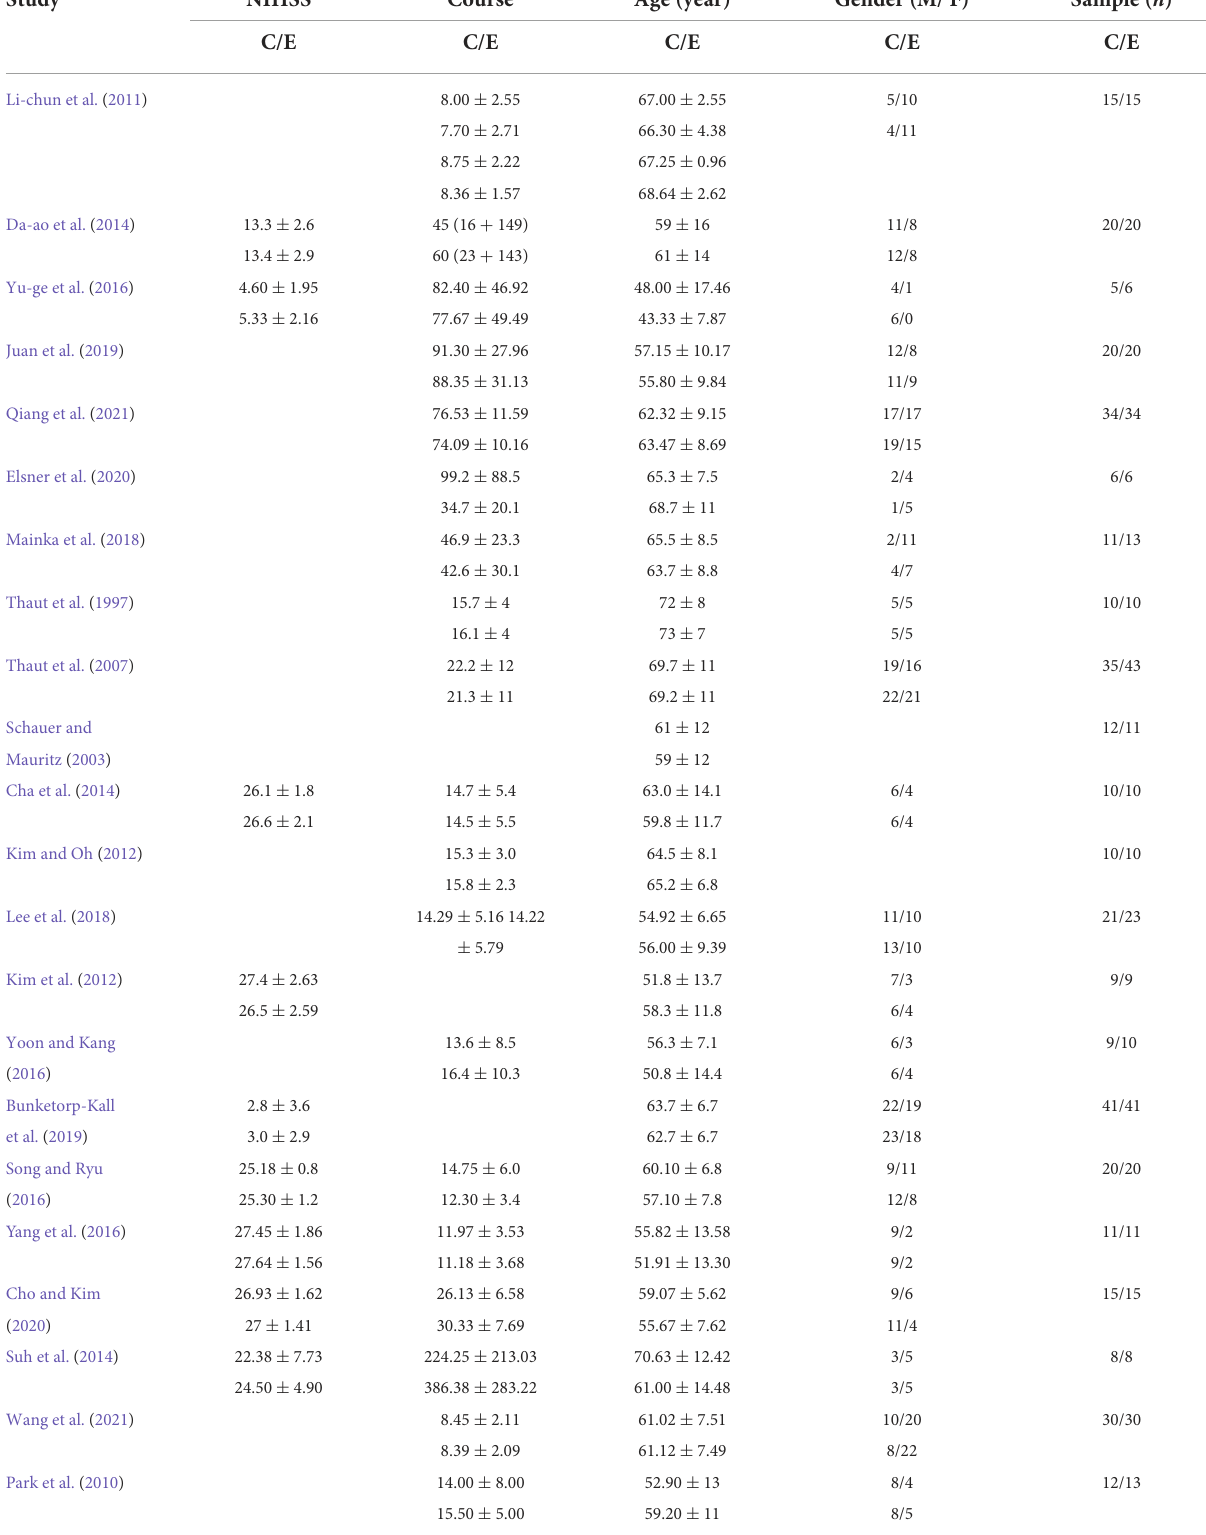
TABLE 2 Characteristics of participants in the included